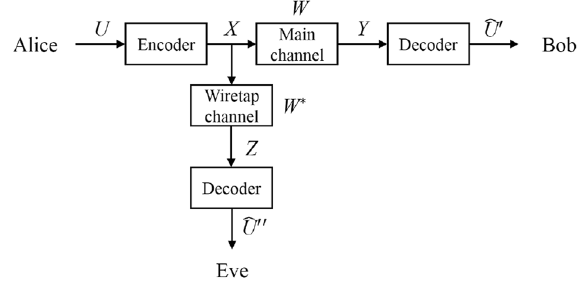
Figure 1. Wiretap channel